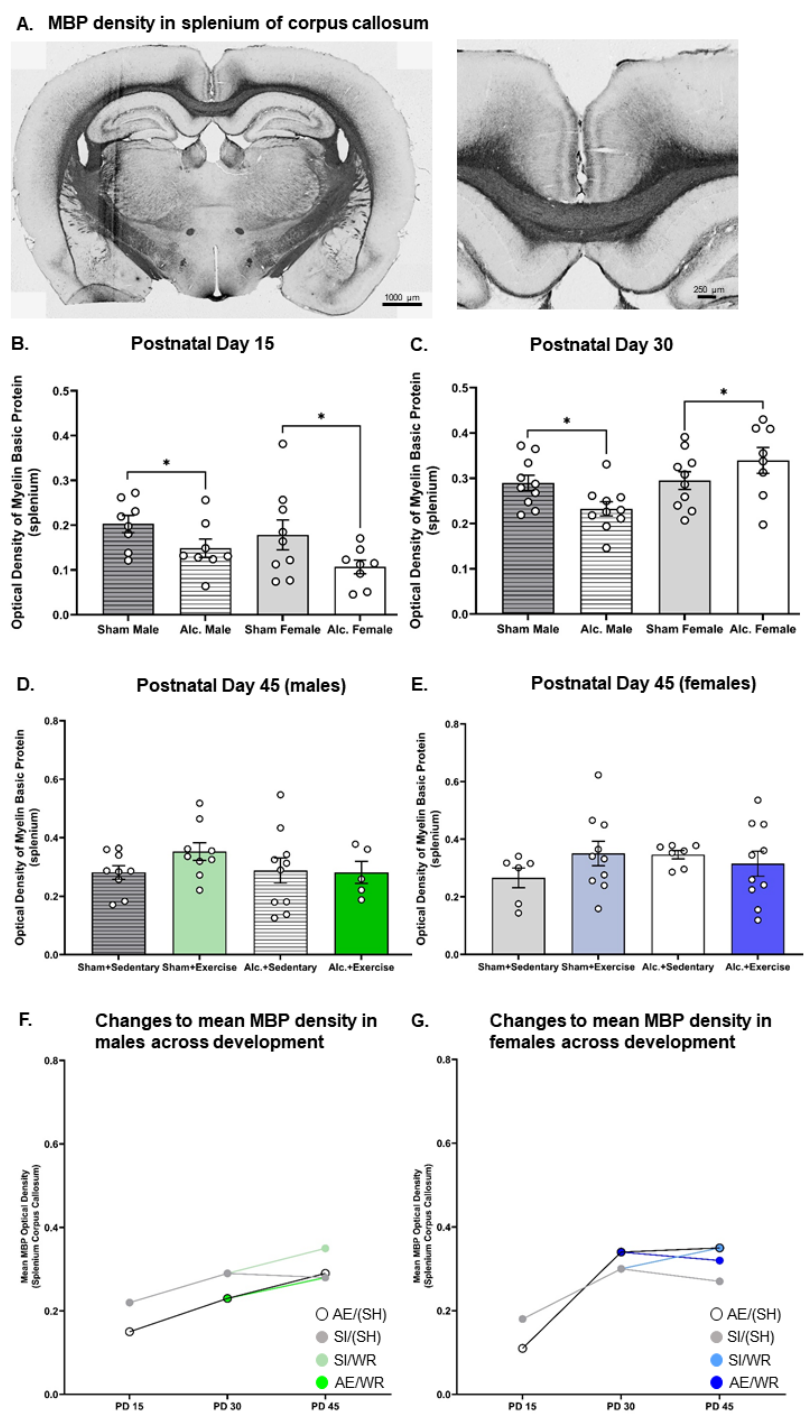
Figure 5. Densitometric analysis of MBP in the splenium of CC from PD 15 to 45. ( A ) Example of histological staining used to visualize MBP in corpus callosum, scale bar = 2 mm (left image) and = 0.75 mm (right image); ( B , C ) Comparison of the optical density of MBP in the splenium of CC in brain tissue extracted from AE and SI rats from both sexes; ( D , E ) Comparison of the optical density of MBP in the splenium of CC in SI/SH, SI/WR, AE/SH, and AE/WR male ( D ) and female ( E ) rats. Each data point in graphs B–E represents the mean estimate per rat and error bars represent ± SEM, * p ≤ 0.05; ( F , G ) Trajectories of MBP production across all time points in the male ( F ) and female ( G ) brain in all postnatal treatment and intervention